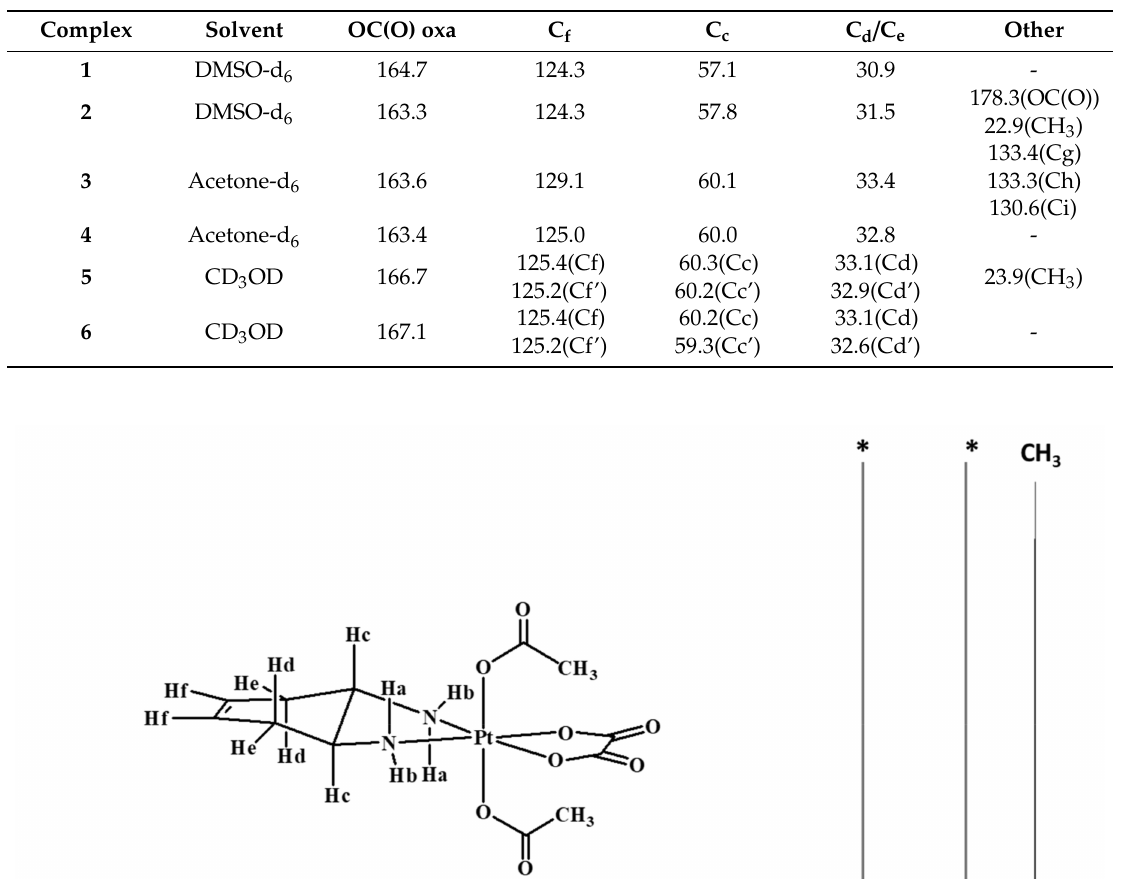
Table 2. Selected 13 C NMR chemical shifts (ppm) for compounds 1 – 6 .